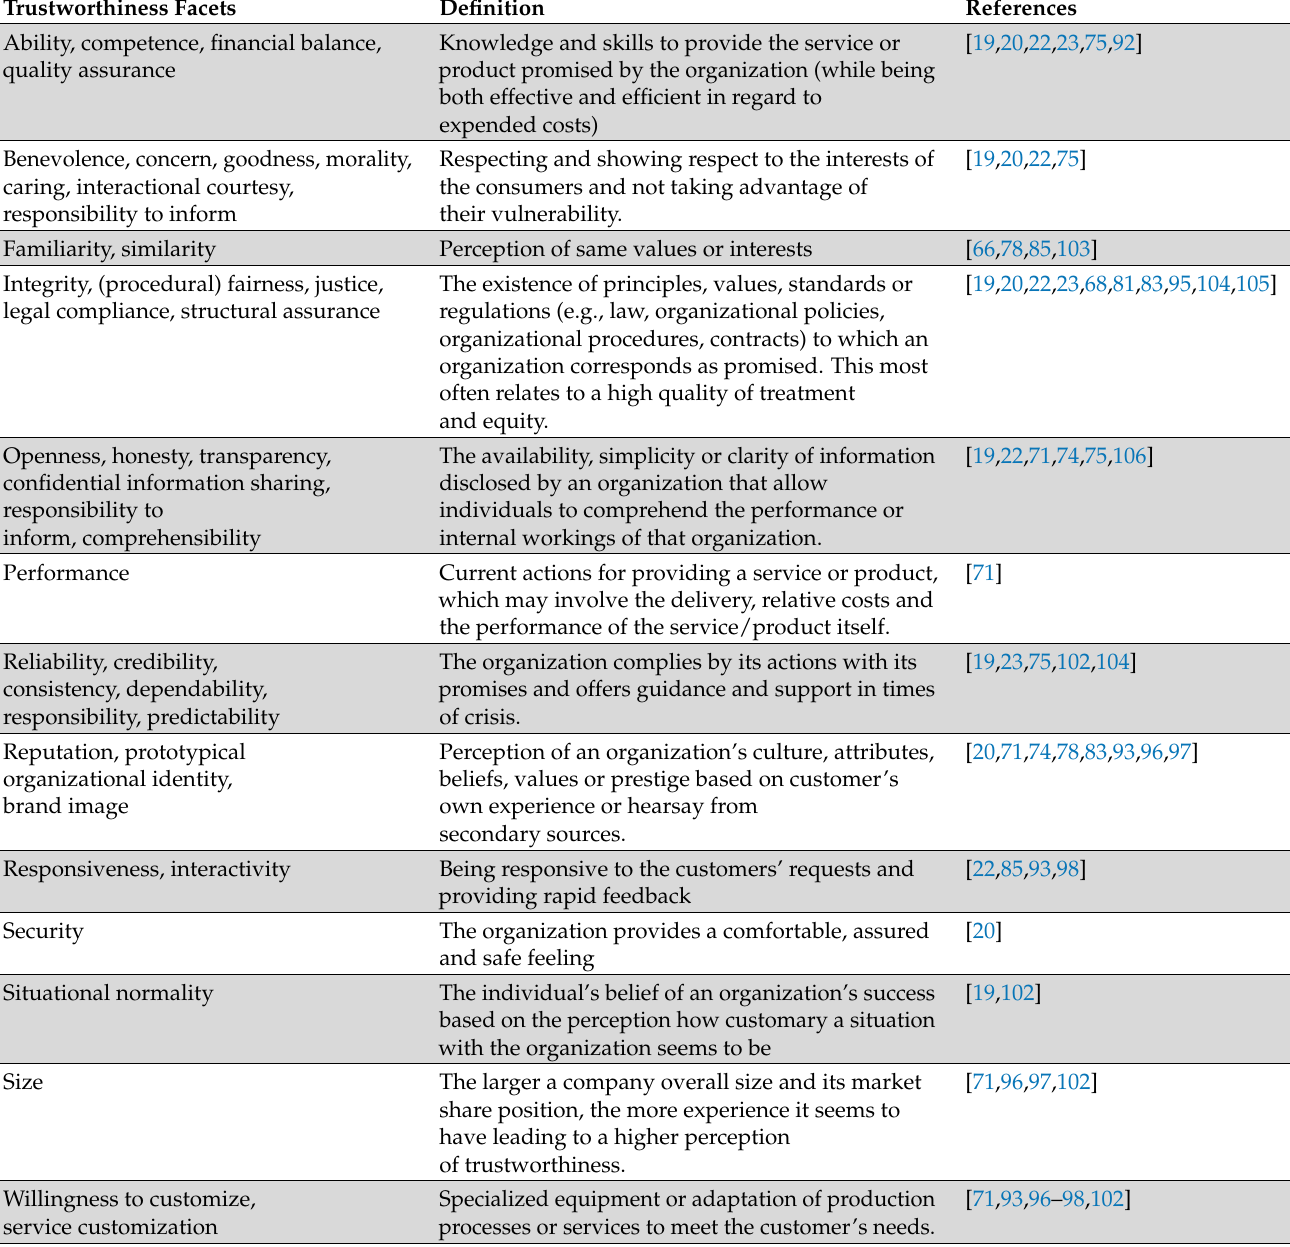
Table A3. Overview of the trustworthiness facets of